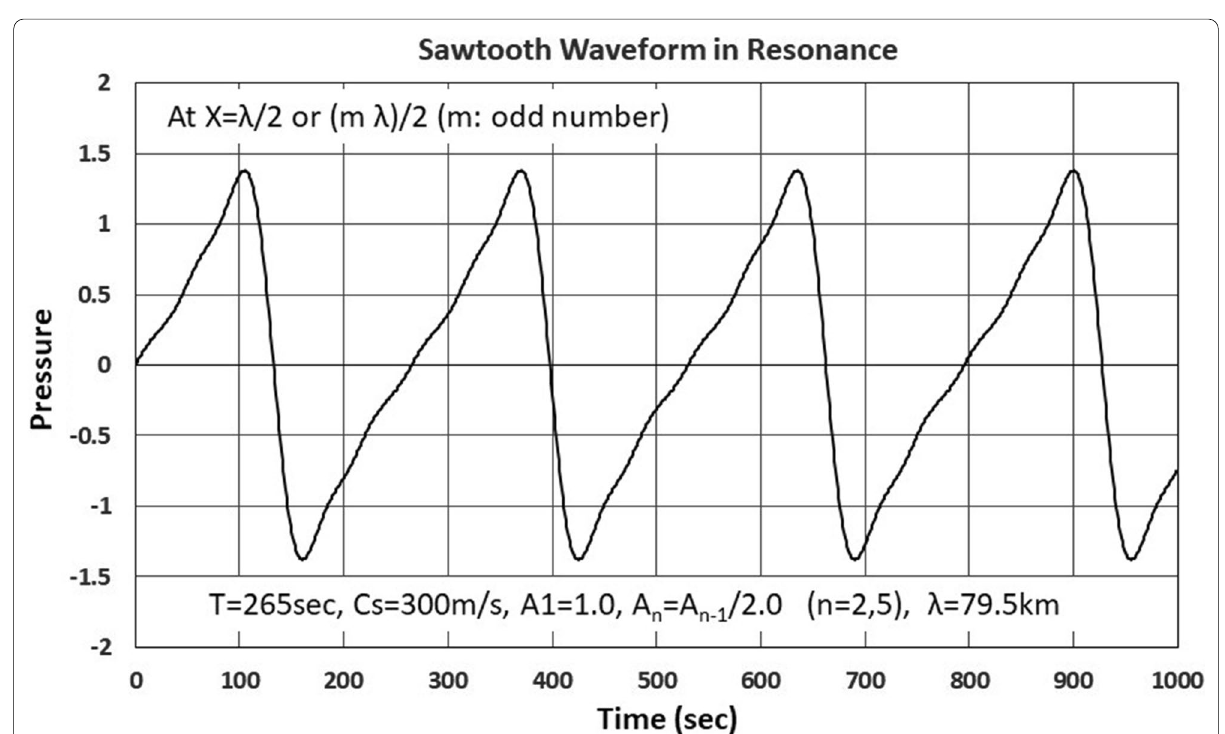
Fig. 14 Pressure variation at altitude 39.75 k or 119.25 km, …. In this case, sound speed Cs wave amplitudes for harmonics ( n